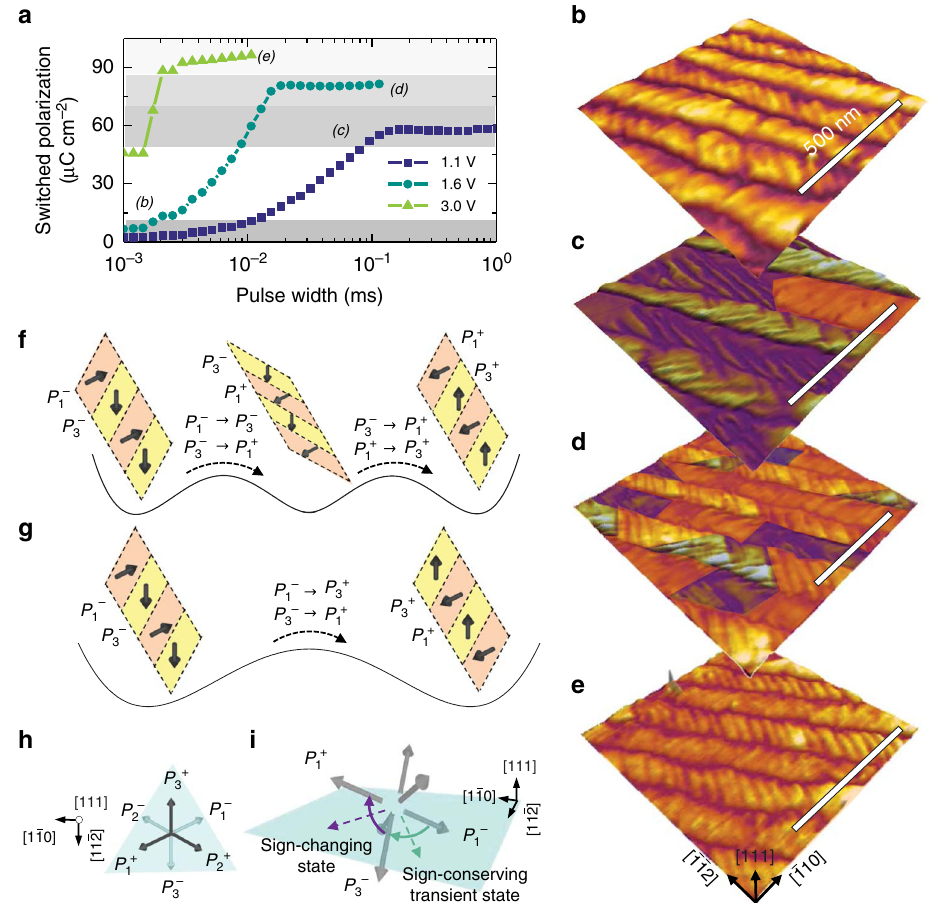
Fig. 4 Visualizing domain structures for multi-state polarization. a Multiple polarization states were pre-poled at pulse voltages of 1.1, 1.6, and 3 V. Piezoresponse force microscope imaging of domain structures and the evolution in the volume fraction of the two types of twinning structures in polarization states for the ( b ) initial, fully up-poled state, the intermediate states poled at ( c ) 1.1 V and ( d ) 1.6 V, as well as e , the fi nal fully down-poled state poled at 3.0 V. In these fi gures, the Type-I twinning structures are shaded yellow-orange and the Type-II twinning structures are shaded blue. Schematics of the f , multi-step switching pathway at low fi elds which transitions from fully down-poled Type-I structures to half down-poled Type-II structures to fully up-poled Type-I structures and ( g ) direct bipolar-like switching pathway at high fi elds which transitions from fully down-poled Type-I structures to fully up- poled Type-I structures. h Plan-view schematic of the six possible polarization variants. i , Schematic illustrating the sign-changing and – conserving switching events with the transient states